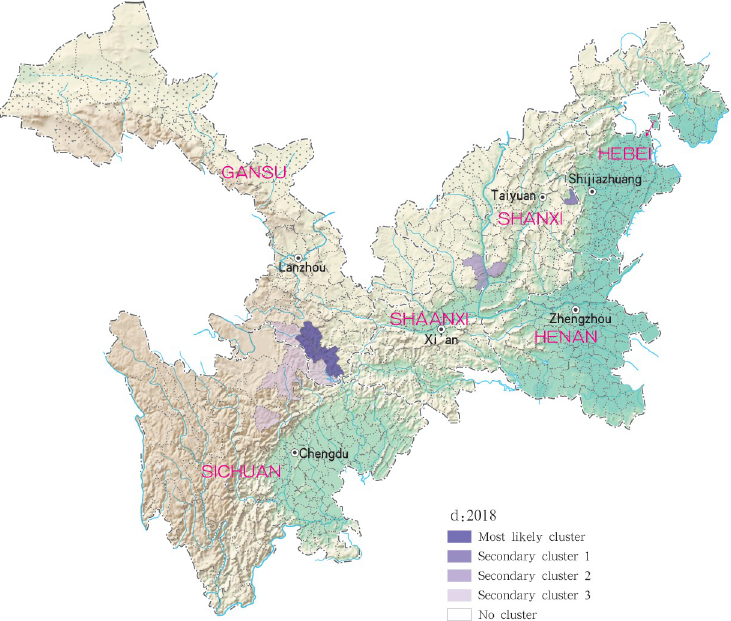
Fig 19. Spatial clustering analysis of mountain-type zoonotic visceral leishmaniasis incidence in 6 provinces, China in 2018.